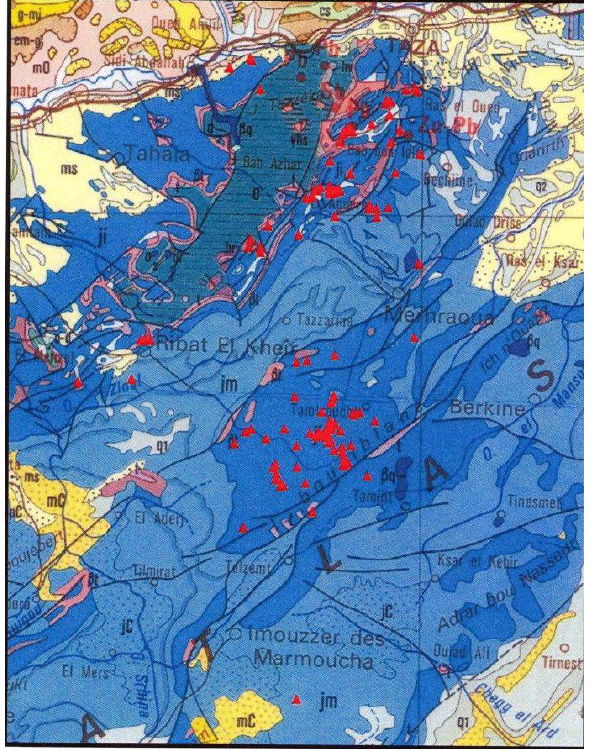
Fig. 5, 6 & 7 respectively: Location of the cave (red dots) of the north of the Atlas mountain on the geological map of Morocco at 1/50000, the Landsat ETM+ satellite imagery and on a SRTM with 30m spatial